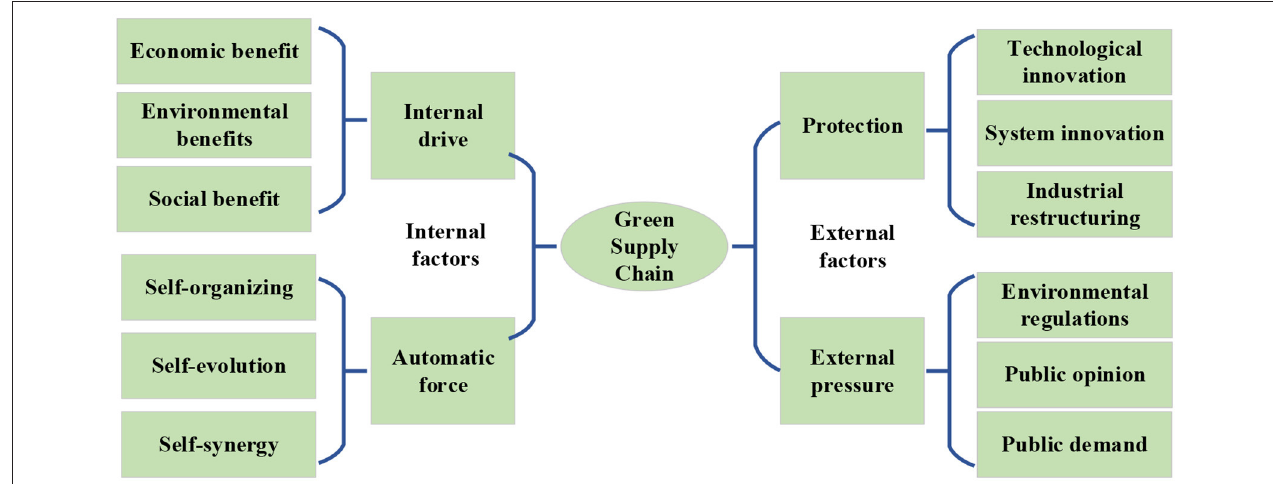
FIGURE 1 | The formation principle of the green supply chain.